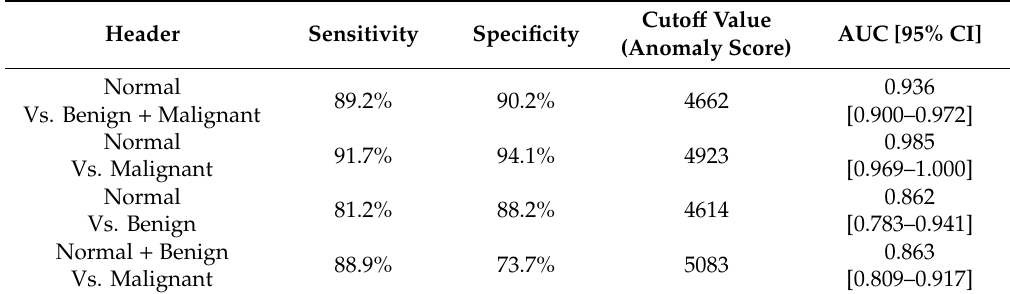
Table 4. Diagnostic performance with anomaly score.